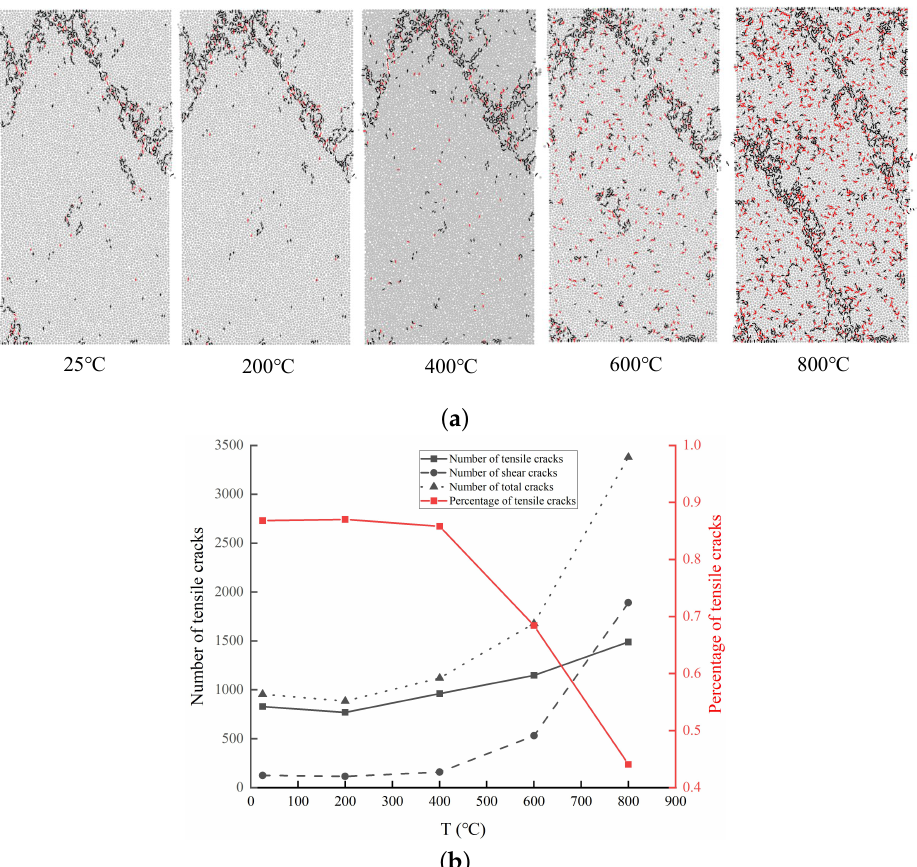
Figure 14. Crack development following uniaxial compression. ( a ) Distribution of crack of model failure; ( b ) The number of